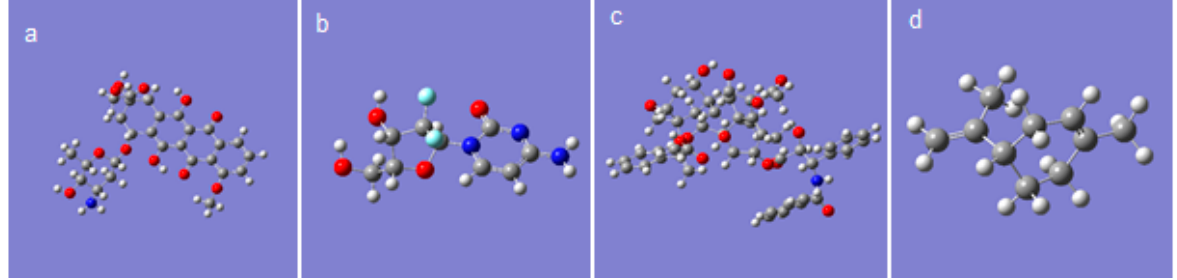
Figure 5. Molecular structures of studied chemical compounds: ( a ) epirubicin; ( b ) gemcitabine; ( c ) paclitaxel; ( d ) limonene.